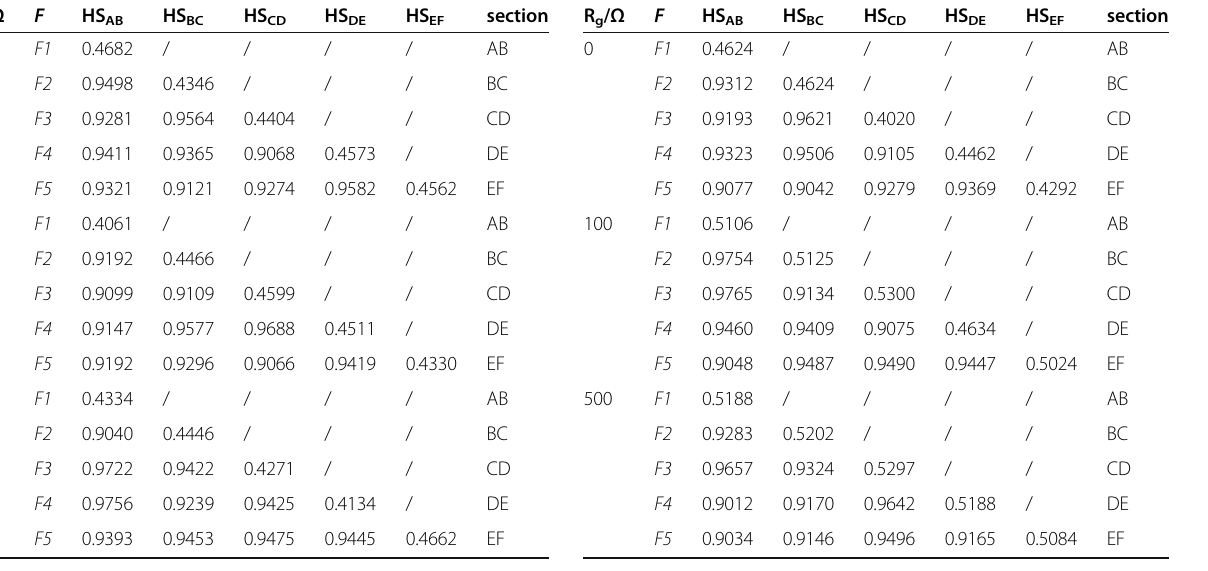
Table 9 Results of the proposed positioning method ( φ = 60 ∘